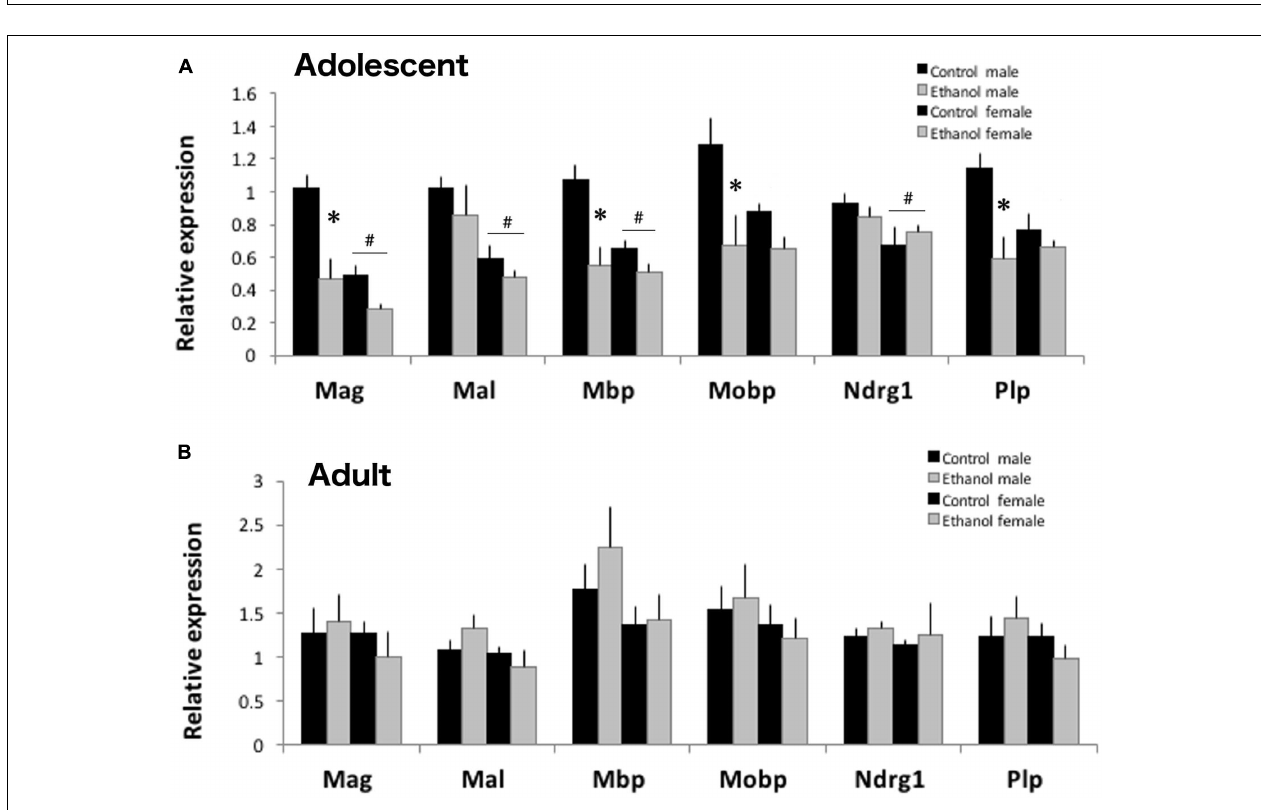
FIGURE 6 | Binge ethanol during adolescents alters mRNA expression of myelin-related genes. (A) Binge ethanol decreased many myelin-related genes including Mag , Mbp , Mobp and Plp mRNA in male and female DBA/2J PFC by qPCR ( n = 4–6, ∗ p < 0.05, interaction between treatment and sex by Two-Way ANOVA). In adolescence, DBA/2J males have more myelin-related mRNA than females ( # p < 0.05, main effect of sex by Two-Way ANOVA). (B) In adulthood, prior binge ethanol did not alter myelin-related gene expression. Sex differences were not found in adults. Data is presented as mean +/–